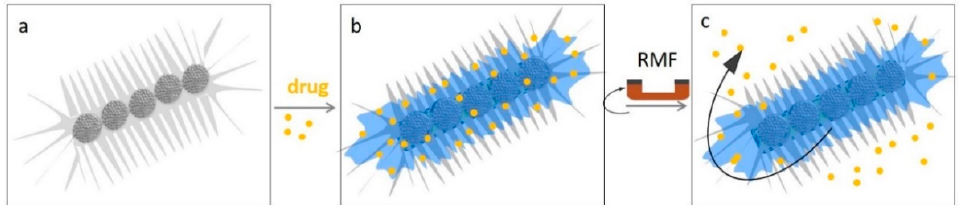
Figure 12. Future application of multifunctional short nanochains carrying drug molecules. ( a ) Schematic representation of short nanochain with radially aligned pores on the surface, whose design and production has recently been described [39]. ( b ) Schematic representation of drug-loaded nanochains. ( c ) Drug release can be triggered through exposure to a rotating magnetic field (RMF). Reproduced from [39] under a Creative Commons